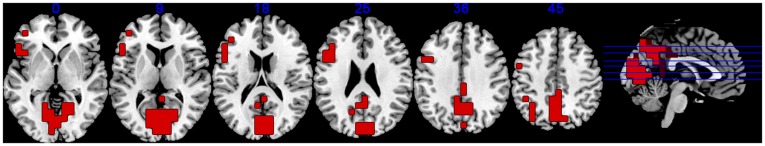
The spatial mask applied to build network.